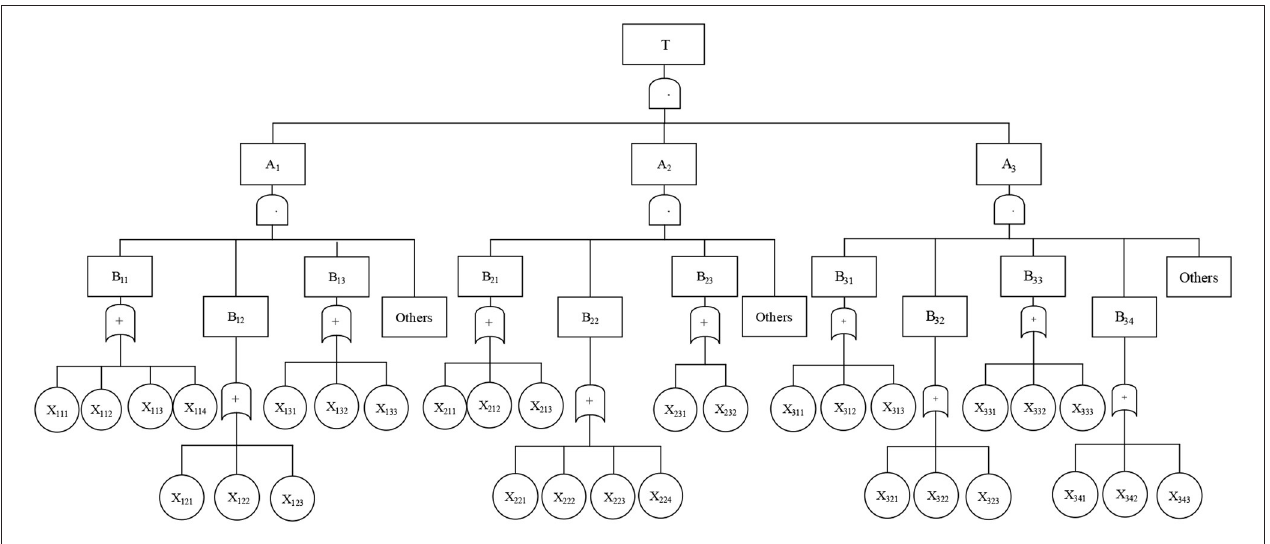
FIGURE 1 | Fault tree of classroom teaching